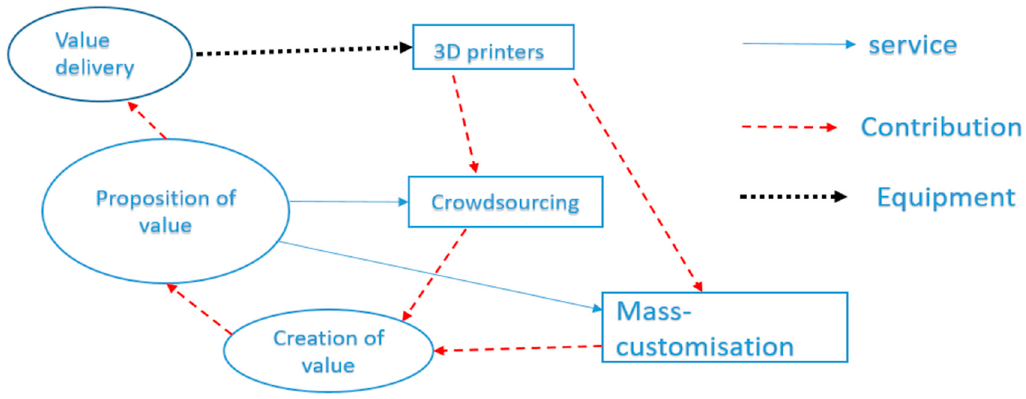
Figure9. Three-dimensionalprintinge ff ectiveinterlinkingbetweendi ff erentcomponentsofthebusiness Figure 9. Three-dimensional printing effective interlinking between different components of the environment. (Adapted from business environment. (Adapted from [66]).